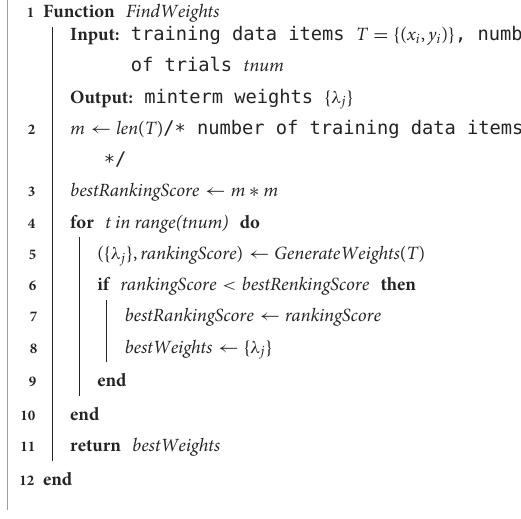
Algorithm 5. Find best minterm weights { λ j } from several local